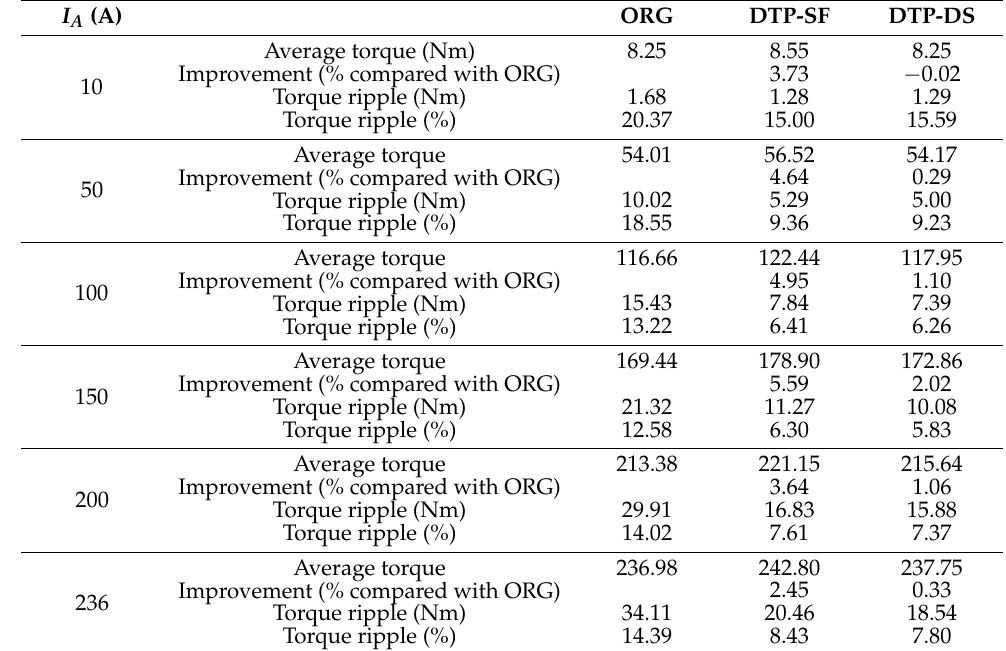
Figure 27. Torque-current amplitude characteristics of different winding configurations with MTPA strategy: ( a ) average torque; ( b ) torque ripple. Table 7. Comparison of torque-current amplitude characteristics of different winding configurations with the MTPA